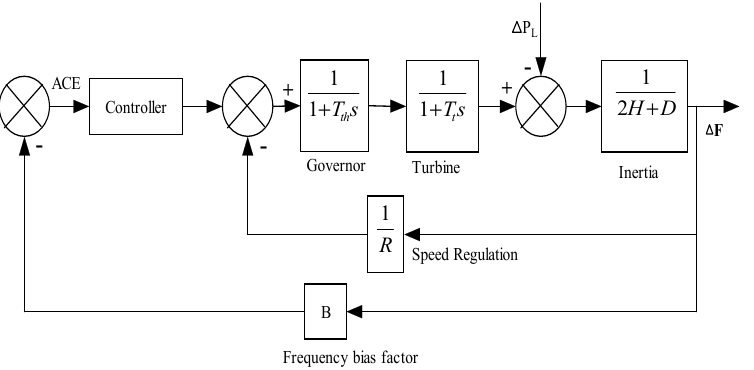
Figure 1. Generalised block diagram of single area LFC of reheat thermal based power system .